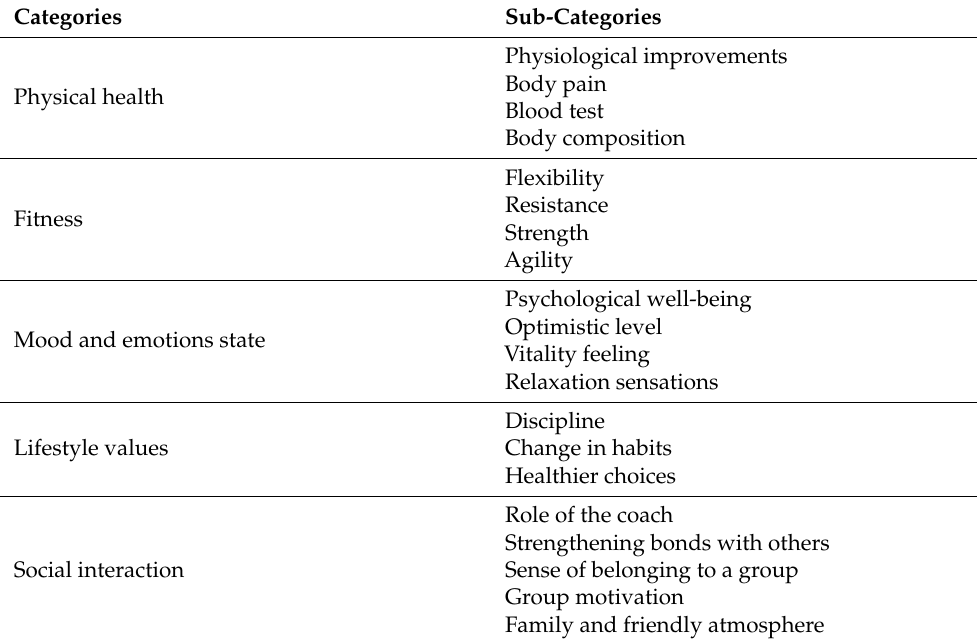
Table 1. The categories and sub-categories of participant’s